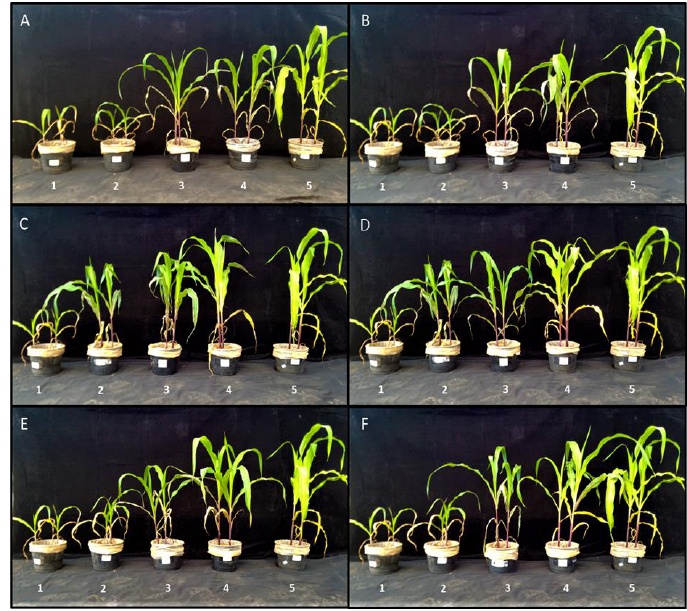
Figure A1. Maize plants at harvest (45 days growth) showing the differences between treatments. ( A ) 1 = Control (T17); 2 = ARP (T13); 3 = ARP + PILC + 25% ac. (T2); 4 = ARP + PILC + 50% ac. (T1); 5 = TSP (T16). ( B ) 1 = Control (T17); 2 = ARP (T13); 3 = ARP + Zeo + 25% ac. (T4); 4 = ARP + Zeo + 50% ac. (T3); 5 = TSP (T16). ( C ) 1 = Control (T17); 2 = BRP (T14); 3 = BRP + PILC + 25% ac. (T6); 4 = BRP + PILC + 50% ac. (T5); 5 = TSP (T16). ( D ) 1 = Control (T17); 2 = BRP (T14); 3 = BRP + Zeo + 25% ac. (T8); 4 = BRP + Zeo + 50% ac. (T7); 5 = TSP (T16). ( E ) 1 = Control (T17); 2 = MRP (T15); 3 = MRP + PILC + 25% ac. (T10); 4 = MRP + PILC + 50% ac. (T9); 5 = TSP (T16). ( F ) 1 = Control (T17); 2 = MRP (T15); 3 = MRP + Zeo + 25% ac. (T12); 4 = MRP + Zeo + 50% ac. (T11); 5 = TSP (T16). ARP = Araxá rock phosphate; BRP = Bayovar rock phosphate; MRP = Morroco rock phosphate; TSP = triplo superphosphate; PILC = pillared clay; Zeo = zeolite. References 1. Lambers, H.; Plaxton, W.C. Phosphorus: Back to the roots. In Phosphorus Metabolism in Plants ; Plaxton, W.C., Lambers, H., Eds.; Wiley-Blackwell: Hoboken, 2015; p. 3–22. 2. Roberts, T.L.; Johnston, A.E. Phosphorus use efficiency and management in agriculture. Resour. Conserv. Recy. 2015 , 105 , 275–281. 3. Shen, J.; Yuan, L.; Zhang, J.; Li, H.; Bai, Z.; Chen, X.; Zhang, W.; Zhang, F. Phosphorus dynamics: From soil to plant. Plant Physiol. 2011 , 156 , 997–1005.